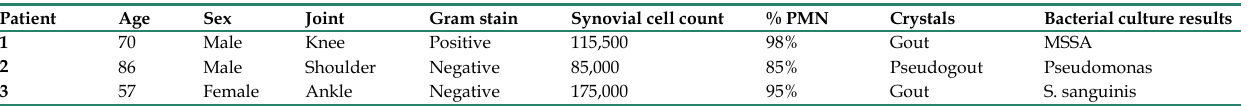
Table 4. Characteristics of the three patients with concomitant crystalline and septic